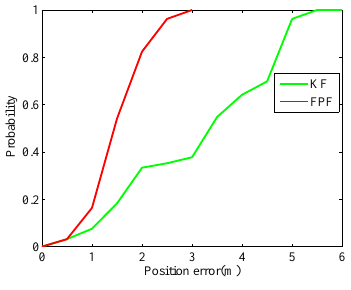
Figure 9. Position errors with different algorithms.